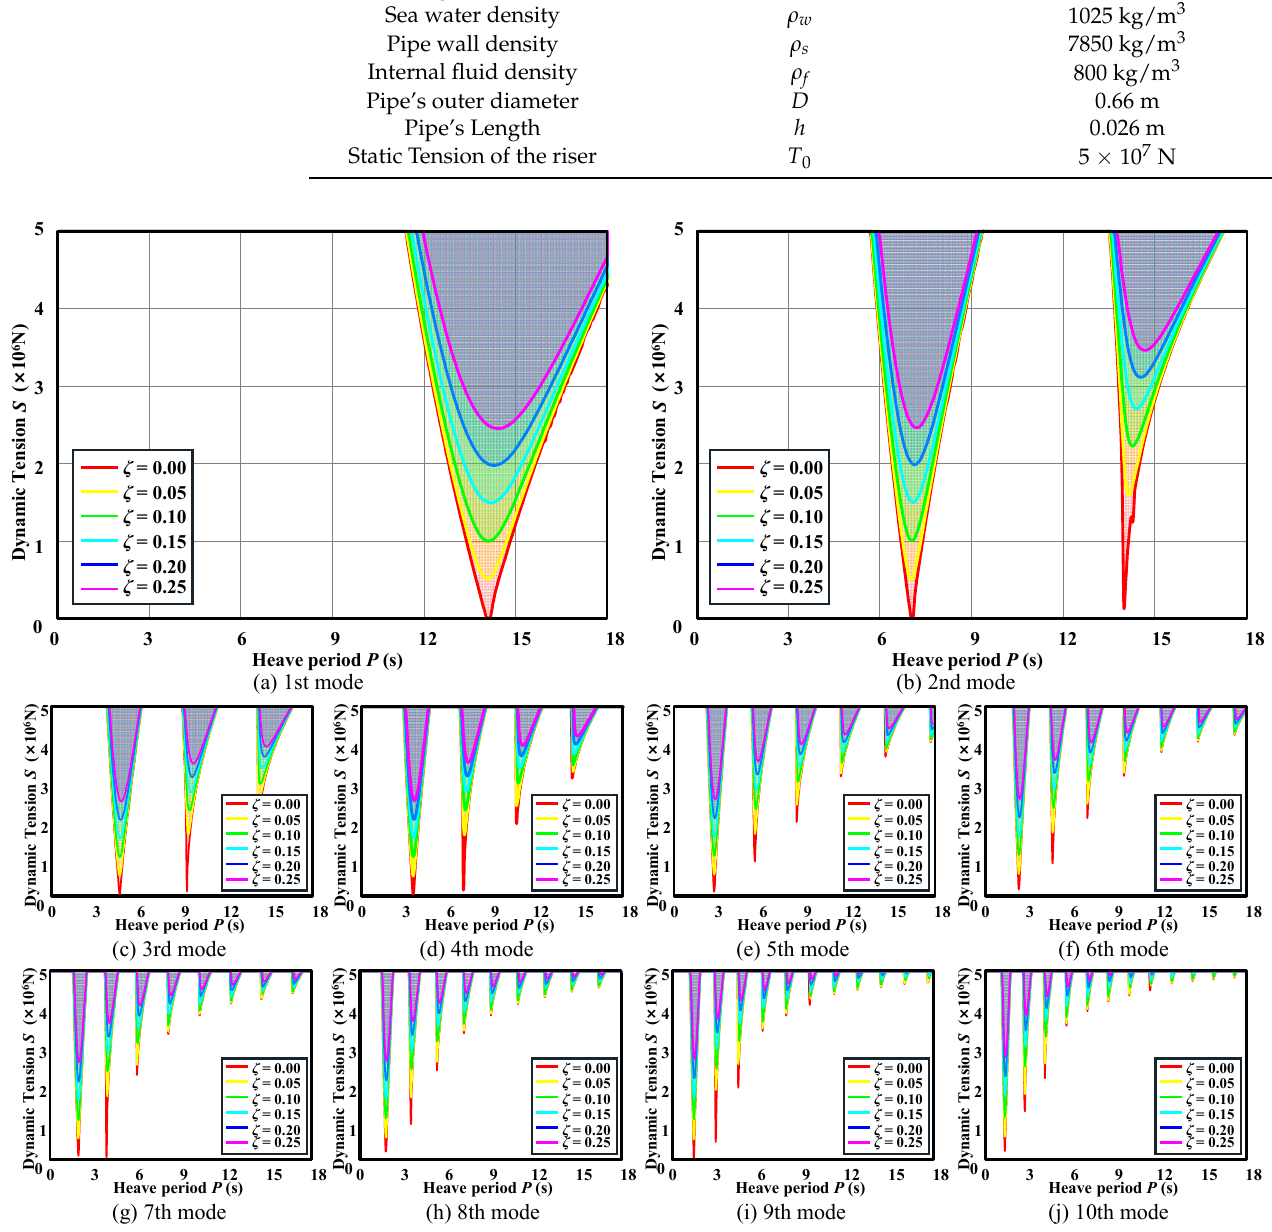
Figure 9. Parametric instability charts of risers with different damping coefficients. Because the coupling terms μ 1 P ij q i , μ 2 Q ij q i , and μ 3 Q ij q i ’ are set to zero, there are no coupling effects between different modes. As a result, the parametric instabilities of dif-